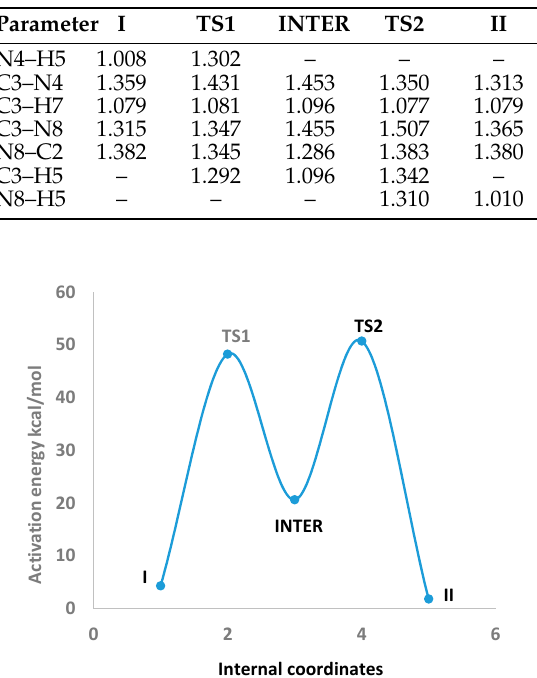
Figure 3. Intrinsic reaction coordinate (IRC) of the tautomerization of Imidazole-4-acetic acid (I) and Imidazole-5-acetic acid (II) through two transition states (TS1 and TS2) and an intermediate (INTER) which were obtained by using B3LYP/6-311++G** level of theory.